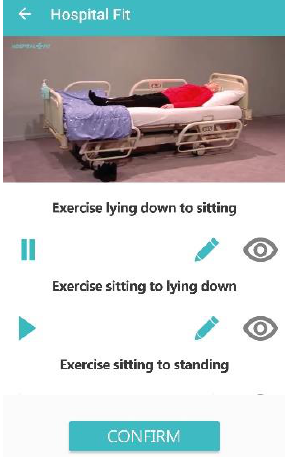
Figure 4. Exercise videos.